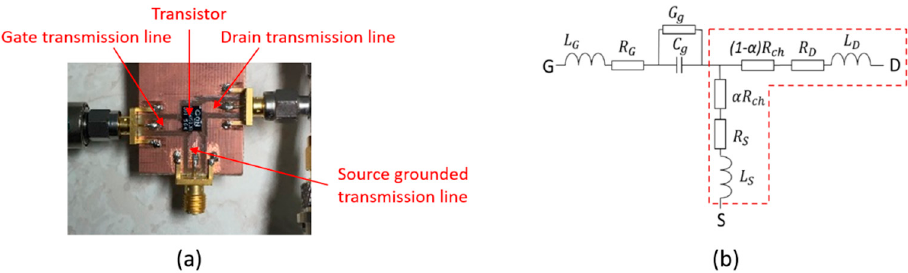
Figure 11. Characterization of the drain–source inductance of a GaN transistor: ( a ) test fixture; ( b ) Cold FET equivalent circuit of the device.